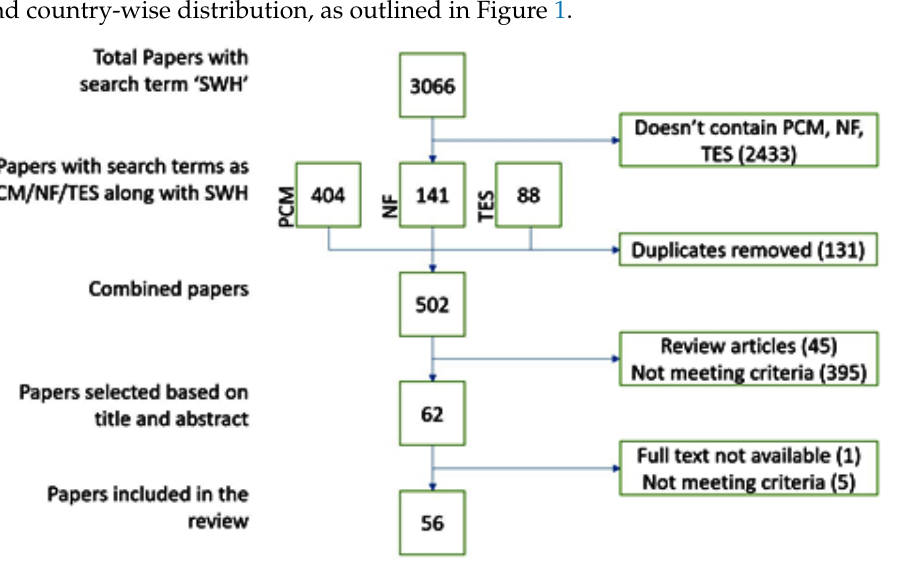
Figure 1. Methodology adopted: flow diagram for article selection.